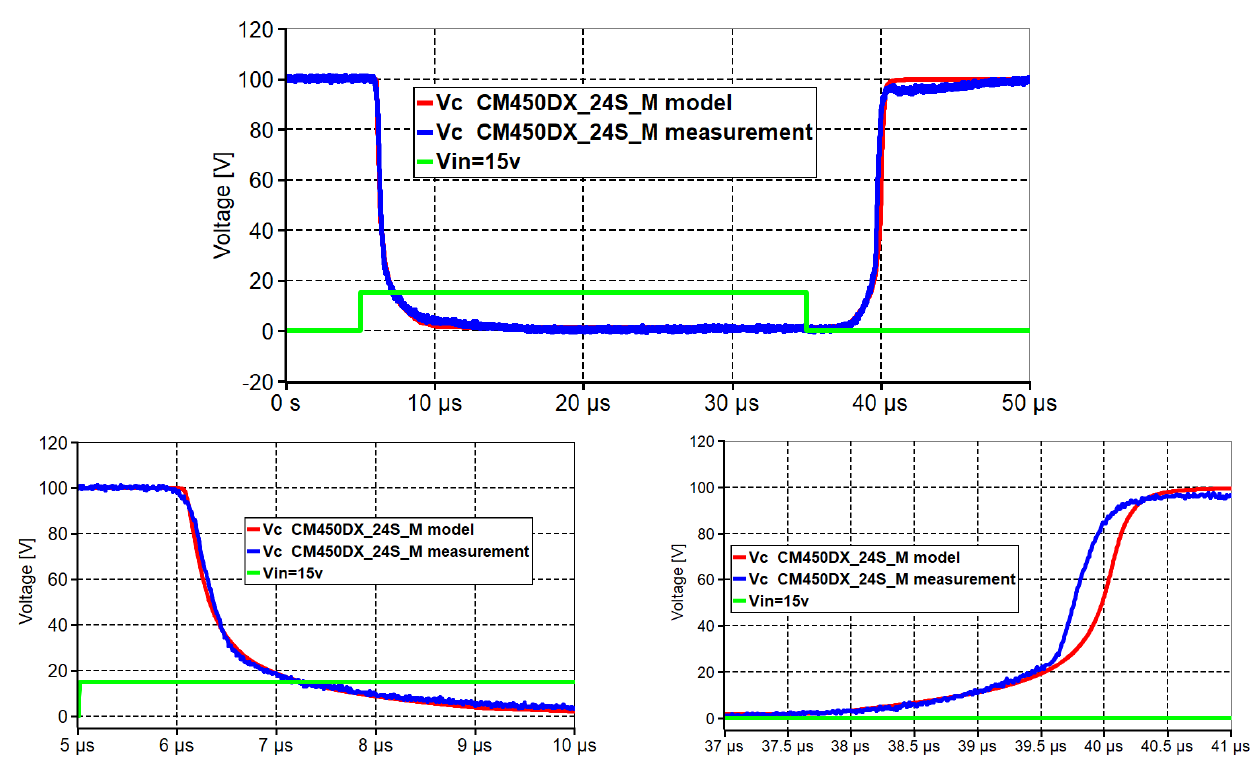
Figure 12. Simulated and measured collector voltages for the Mitsubishi Electric CM450DX-24S module.